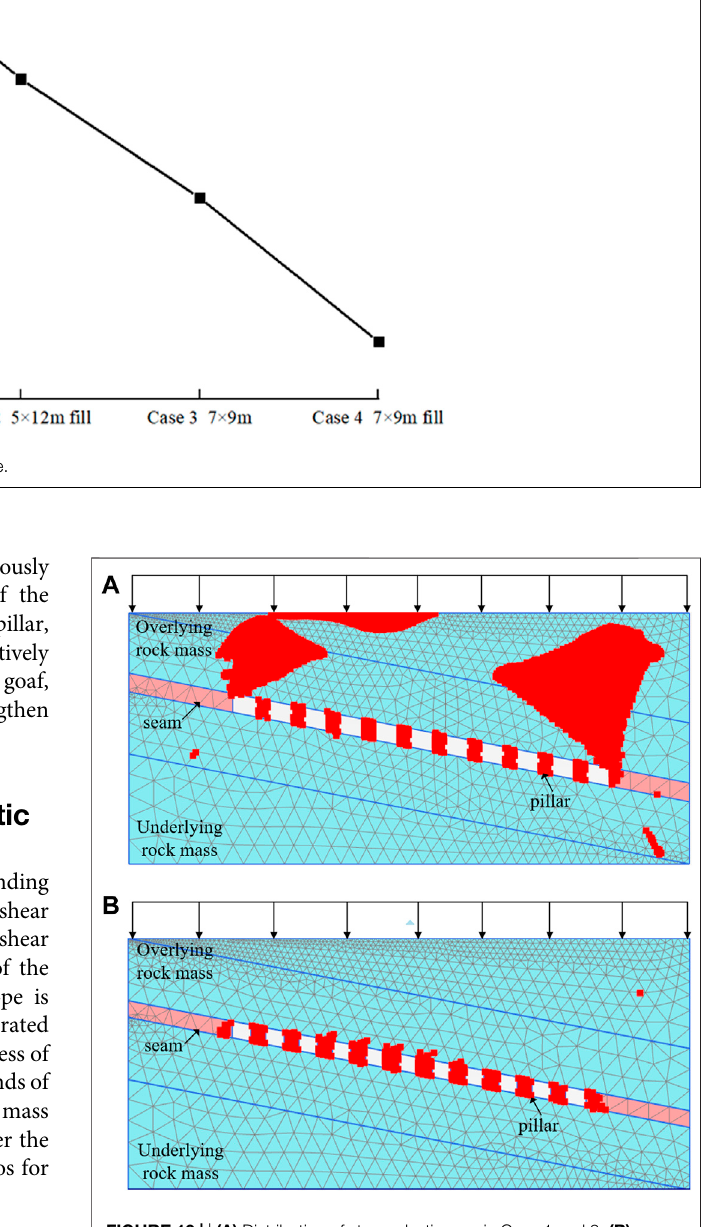
FIGURE 10 | | (A) Distribution of stope plastic area in Case 1 and 3. (B) Distribution of stope plastic area in Case 1 and